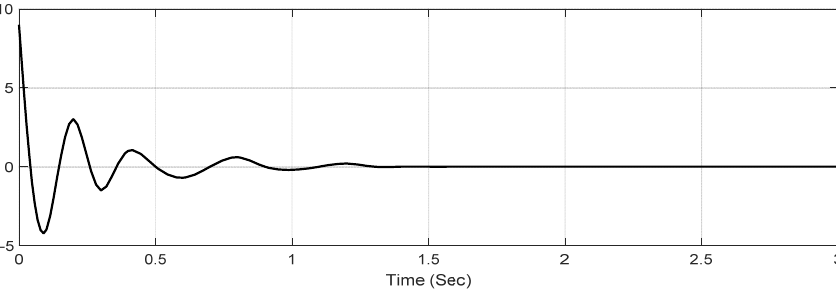
Figure 9. The control signal.